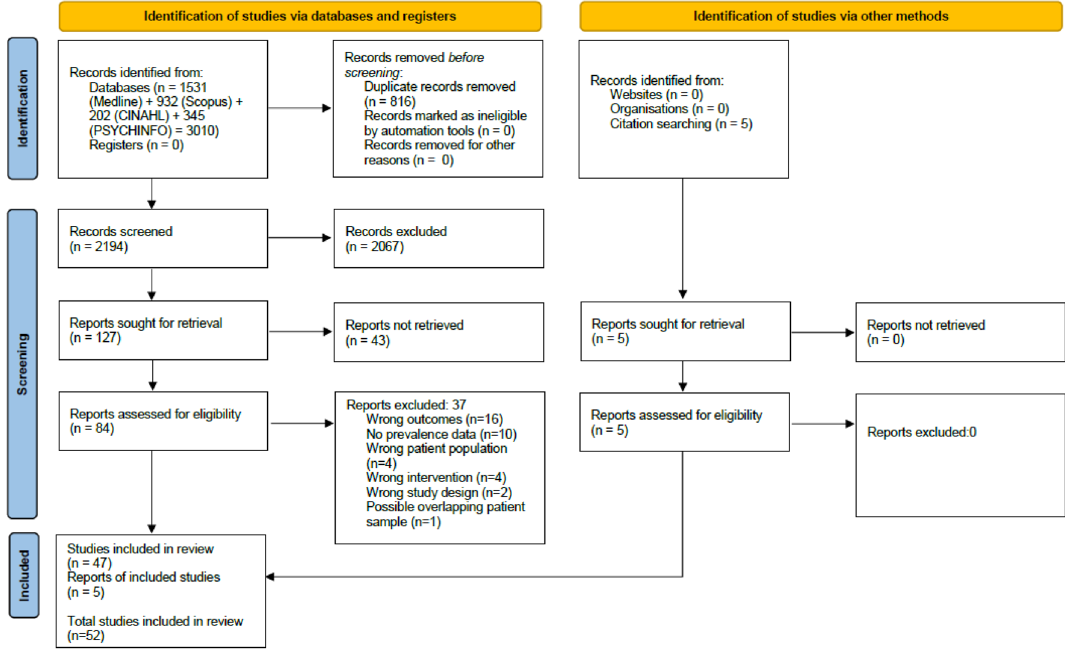
Figure 1. The PRISMA 28 flow diagram for the systematic review detailing the databases searched, the number of abstracts screened and the full texts